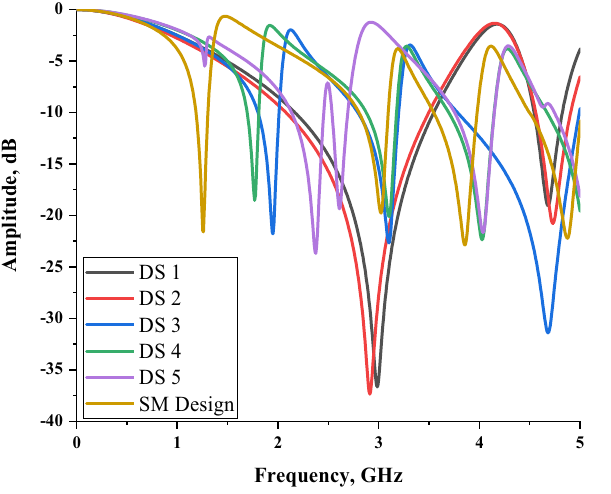
Figure 6. Transmission coefficient of all design